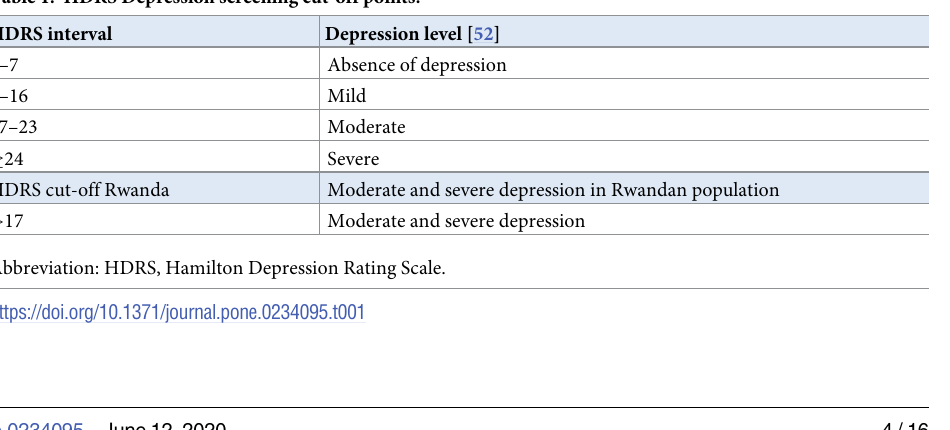
Table 1. HDRS Depression screening cut-off